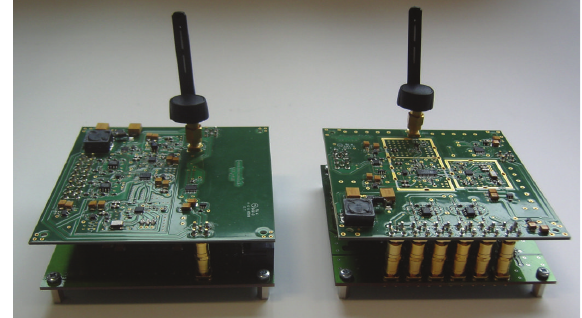
Figure 8: MARS receive and transmit